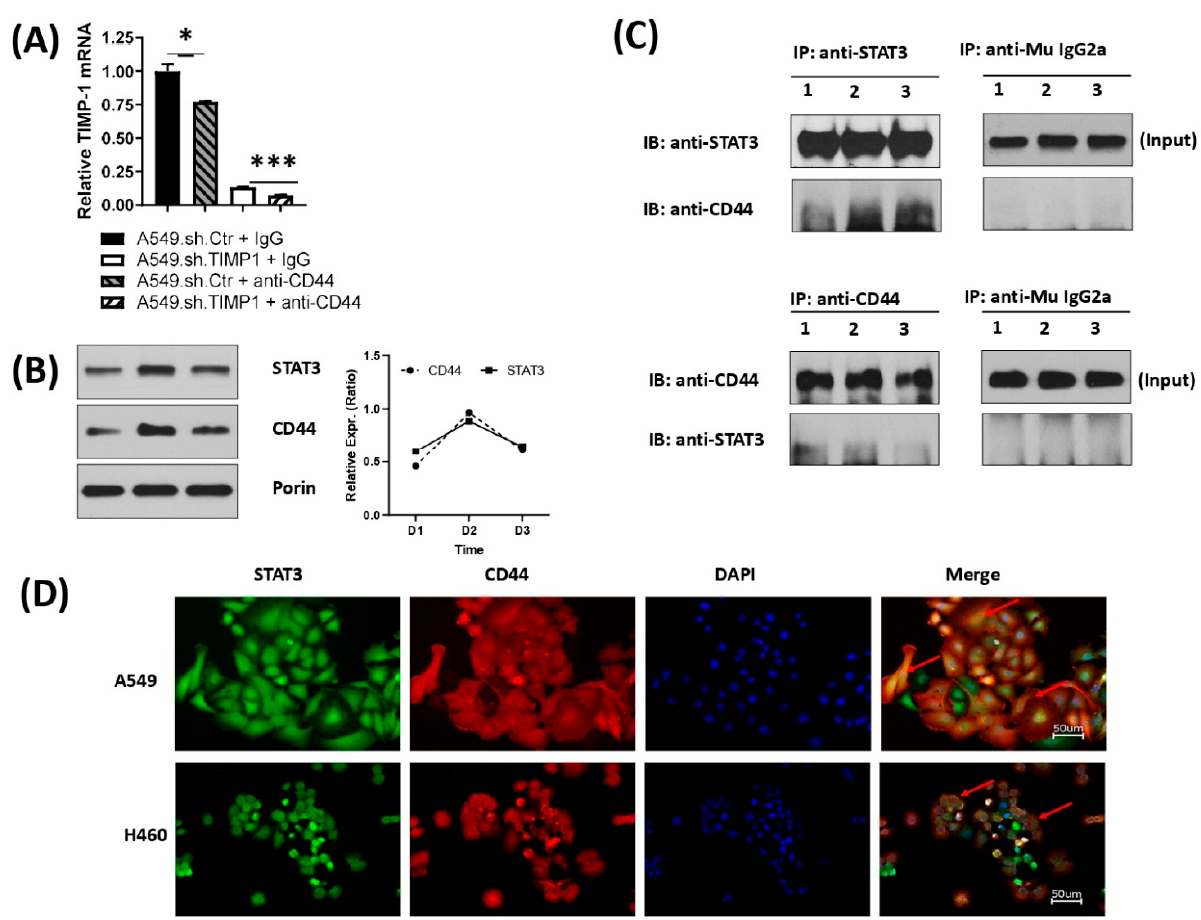
Figure 4. Correlation and interaction of mitochondrial STAT3 with CD44 upon TIMP-1 modulation.